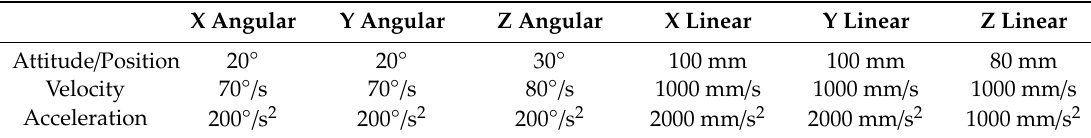
Figure 12. Stewart platform (SP) physical and simulation model. Table 8. Limit parameters of SP in xyz direction.